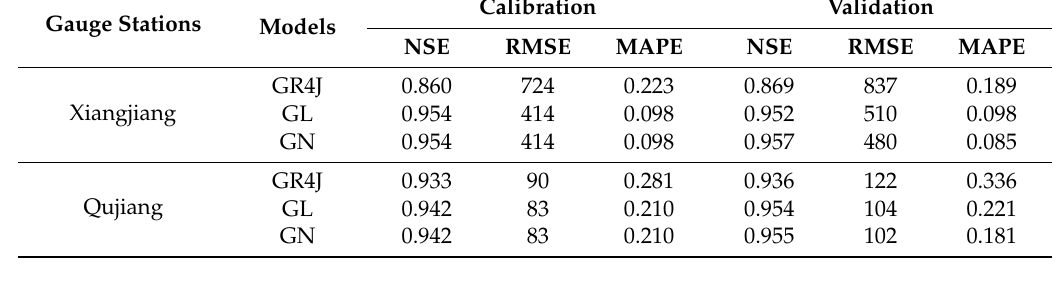
Table 3. Performance indicators for GR4J and the hybrid models.